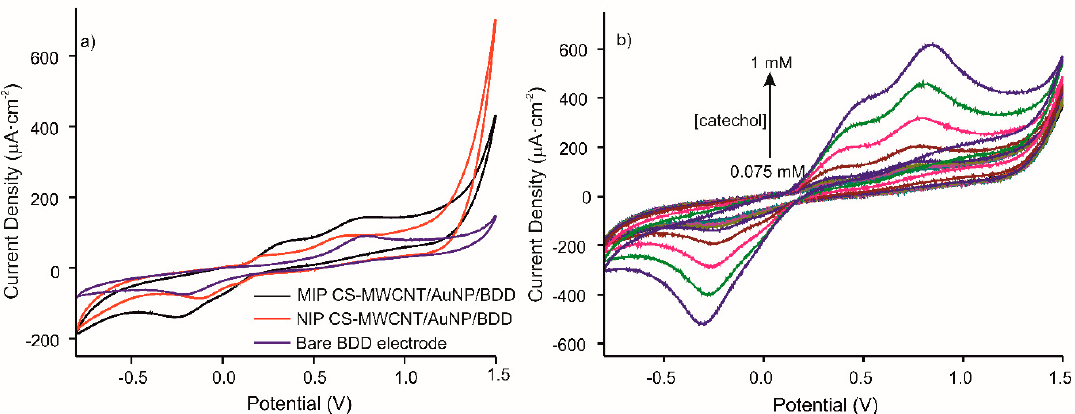
Figure 4. Voltammetric responses of ( a ) MIP CS-MWCNT / AuNP nanocomposite / BDD sensor in black, NIP CS-MWCNT / AuNP nanocomposite / BDD sensor in red and bare electrode in blue, in 10 − 4 M catechol in 0.1 M, pH 7.4 PBS solution and ( b ) MIP CS-MWCNT / AuNP nanocomposite / BDD to increased concentration of catechol (0.075, 0.1, 0.25, 0.5, 0.75, and 1 mM) in 0.1 M, pH 7.4 PBS solution.